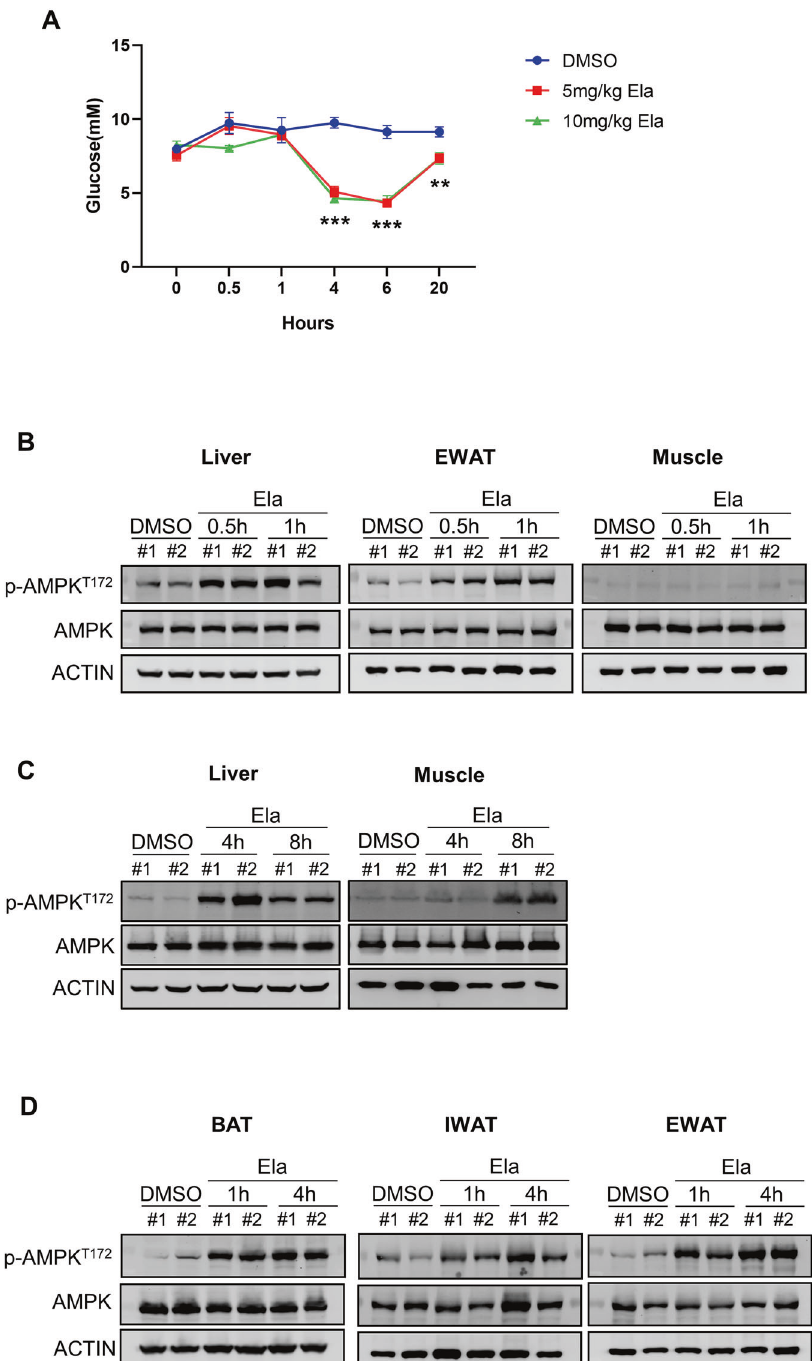
Fig. 3 Ela activates AMPK in the liver and adipose tissues. A Wild-type C57BL/6 mice were intraperitoneally injected with DMSO, 5 mg/kg Ela or 10 mg/kg Ela. Blood glucose level was monitored at 0 h, 0.5 h, 1 h, 4 h, 6 h, and 20 h after injection n = 5. B Wild-type C57BL/6 mice were intraperitoneally injected with DMSO or Ela (80 mg/kg). Mice livers, EWAT, and muscles were harvested 0.5 h and 1 h after injection. WB analysis was performed with the indicated antibodies. C Wild-type C57BL/6 mice were intraperitoneally injected with DMSO or Ela (40 mg/kg). Mice livers and muscles were harvested 4 h and 8 h after injection. WB analysis was performed with the indicated antibodies. D Wild-type C57BL/6 mice were intraperitoneally injected with DMSO or Ela (80 mg/kg). Adipose tissues from different fat-pad depots were harvested 1 h and 4 h after injection. WB analysis was performed with the indicated antibodies. Data are expressed as mean ± SEM. ** P < 0.01, *** P < 0.001 for the indicated comparisons by two-way ANOVA. DISCUSSION were elevated by Ela in a dose-dependent manner (Fig. 7f and g), Numerous studies employing genetic and obesity models have which is consistent with AMPK activation by an Ela dose of 0.2 μ M. revealed a promising role for AMPK as a pharmacological target in Thus, these results demonstrate that Ela promotes glucose the treatment of diverse metabolic disorders such as obesity, type- consumption and fatty acid oxidation.